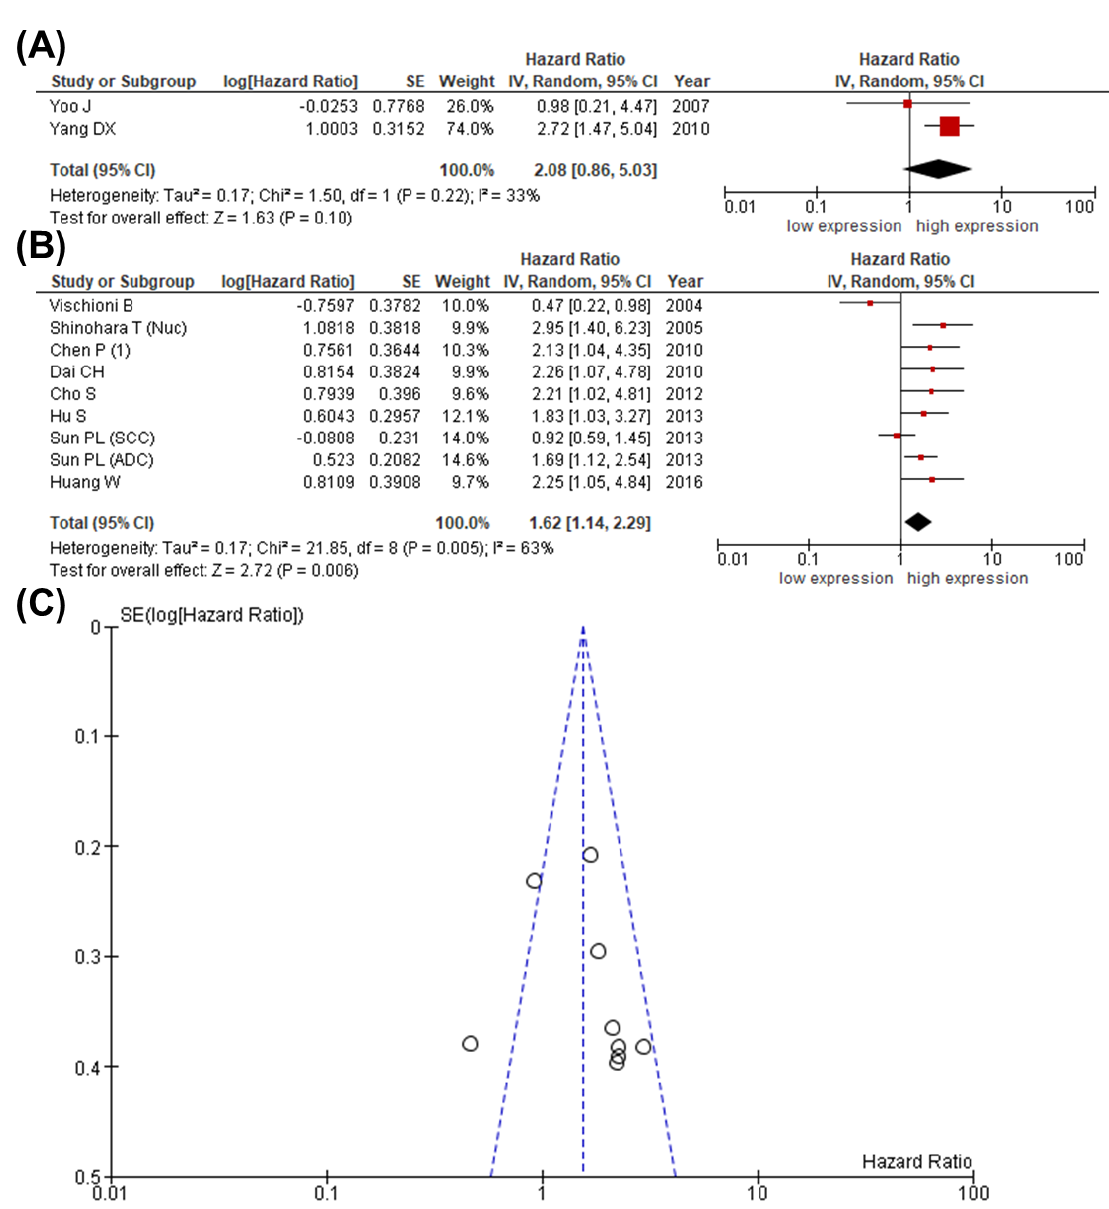
Figure 4. Meta-analysis comparing expression of survivin with DSS and DFS in patients with lung cancer. The forest plot reflects the individual and pooled HR with 95% CI to assess the association between survivin and ( A ) DSS or ( B ) DFS. Heterogeneity was quantified by the Cochrane Q test (Chi-squared test; Chi 2 ) and inconsistency (I 2 ). ( C ) The funnel plot for DFS demonstrates a symmetric distribution. The Y -axis represents the standard error (SE), and the x -axis represents the study ’ s result.